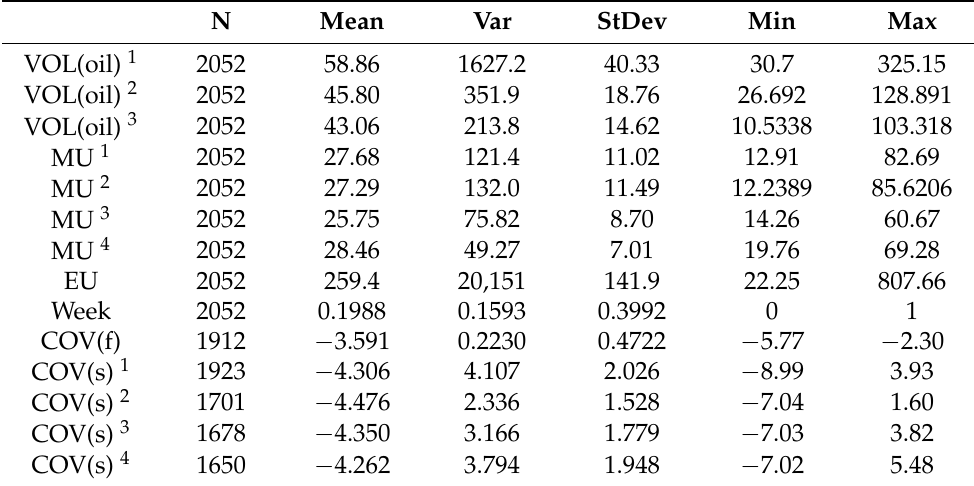
Table 1. Descriptive